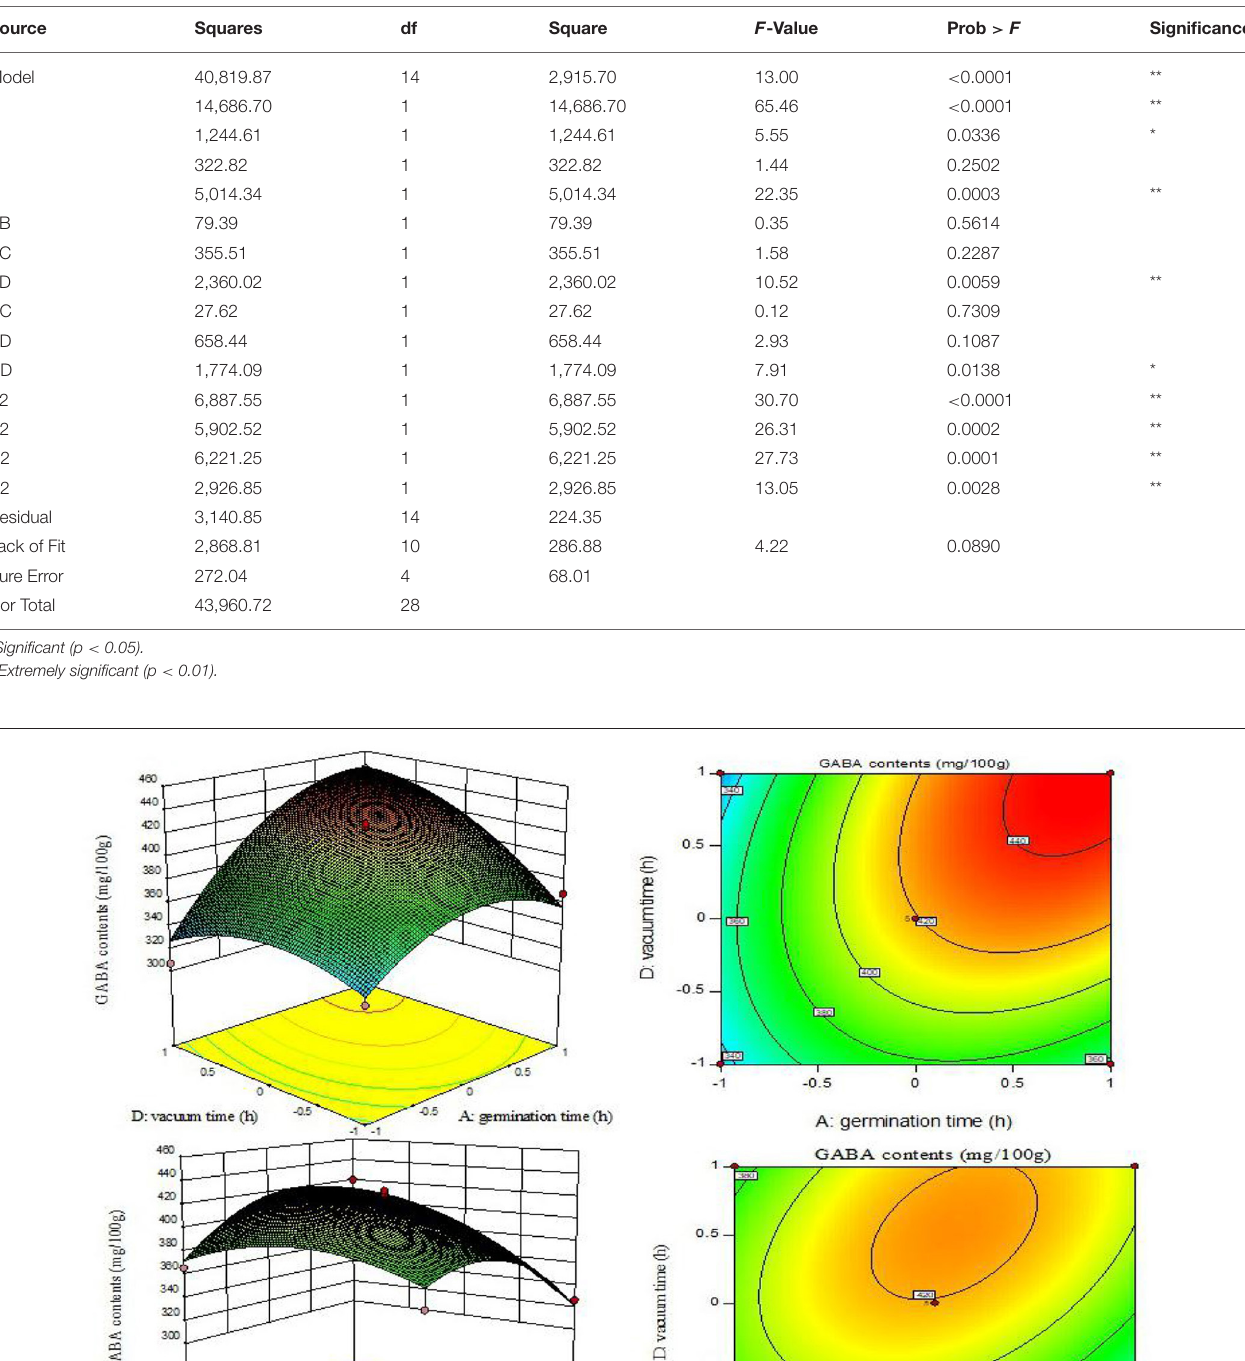
Frontiers in Nutrition |